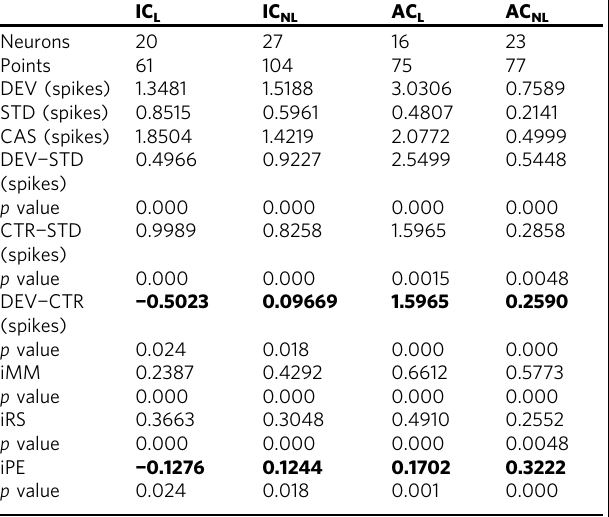
Table 2 Summary of awake data